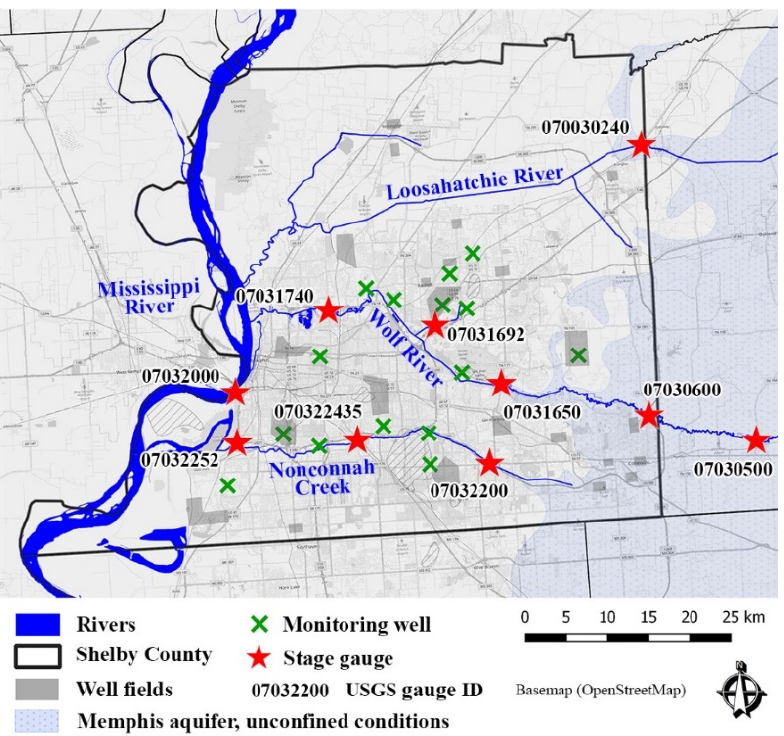
Figure 6. Stream gauging locations along main rivers. Green markers are monitoring wells in the shallow aquifer used in estimating riverbed conductance per unit length.